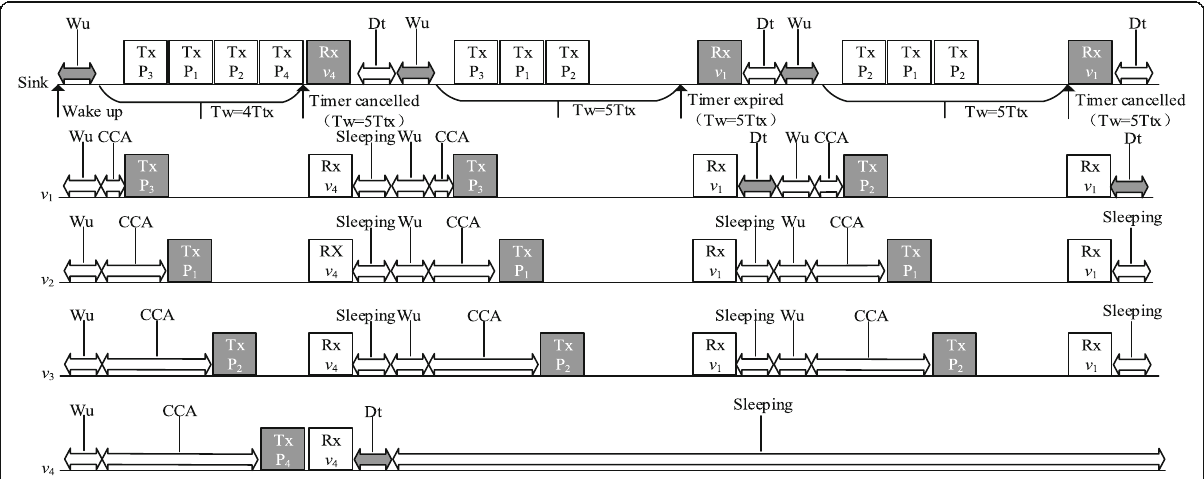
Algorithm 1. Symbols used in Algorithm 1 and their def- initions are given in Table 3.